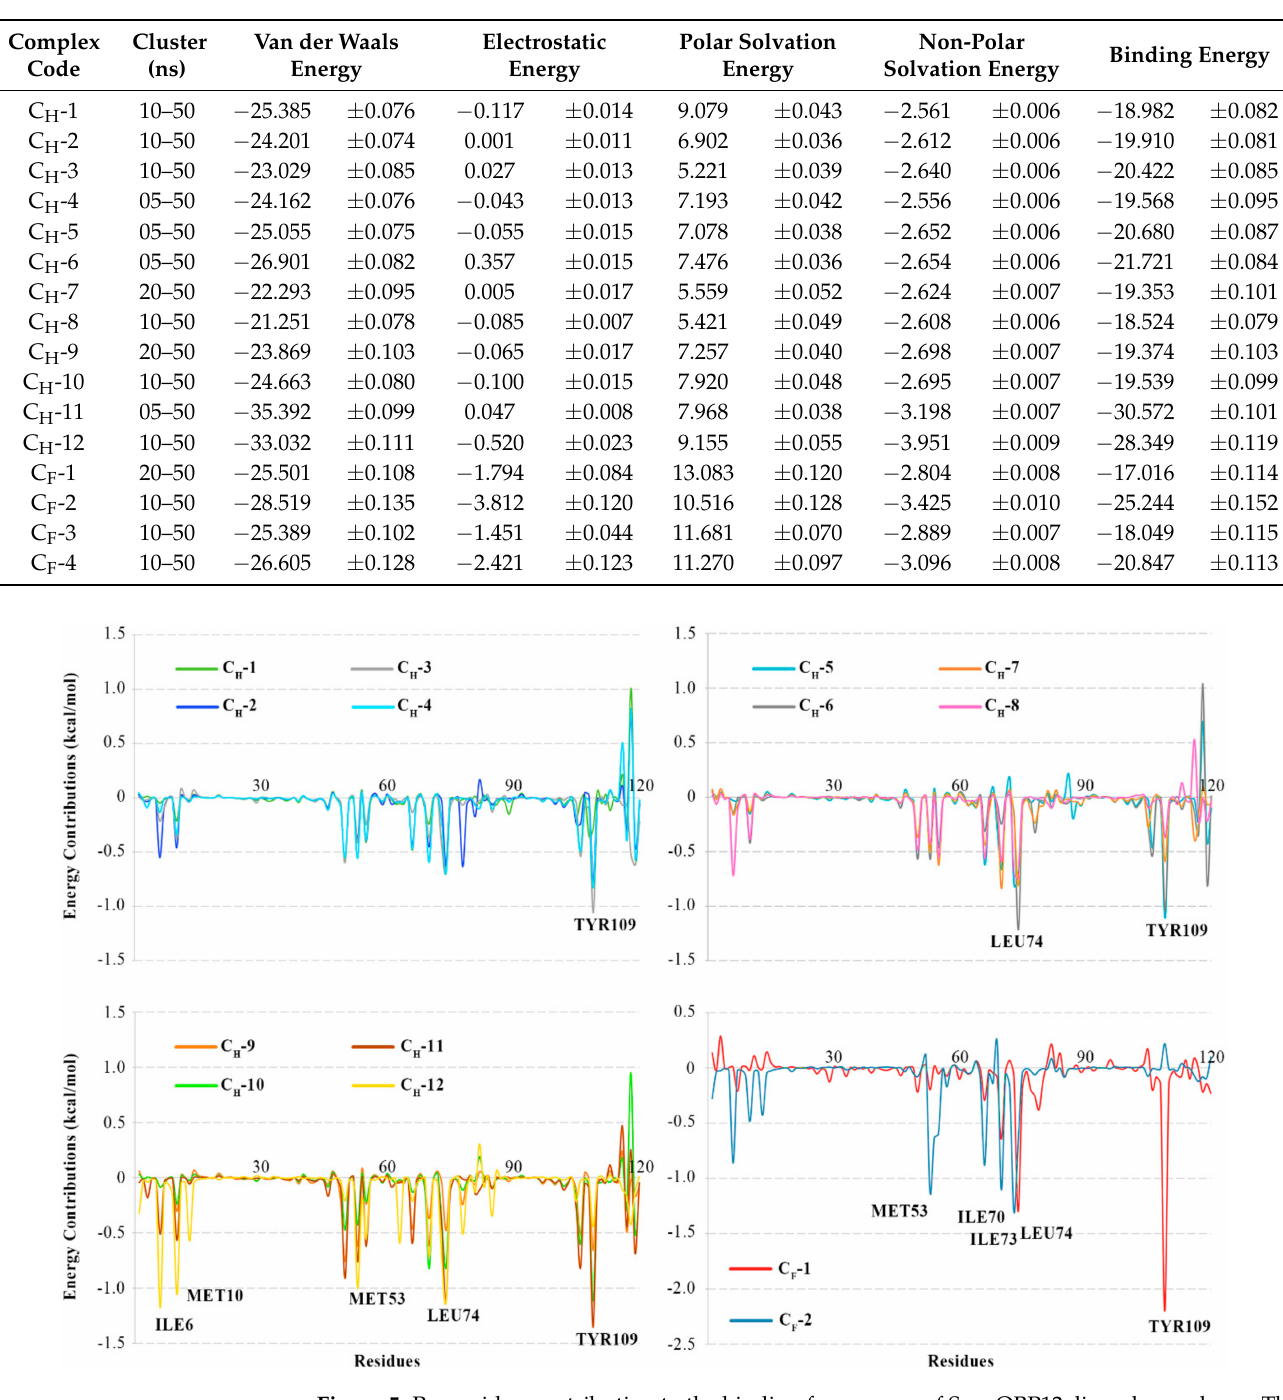
Figure 5. Per-residue contribution to the binding free energy of SnocOBP12–ligand complexes. The residues with binding energy below − 1.0 kcal/mol were individually